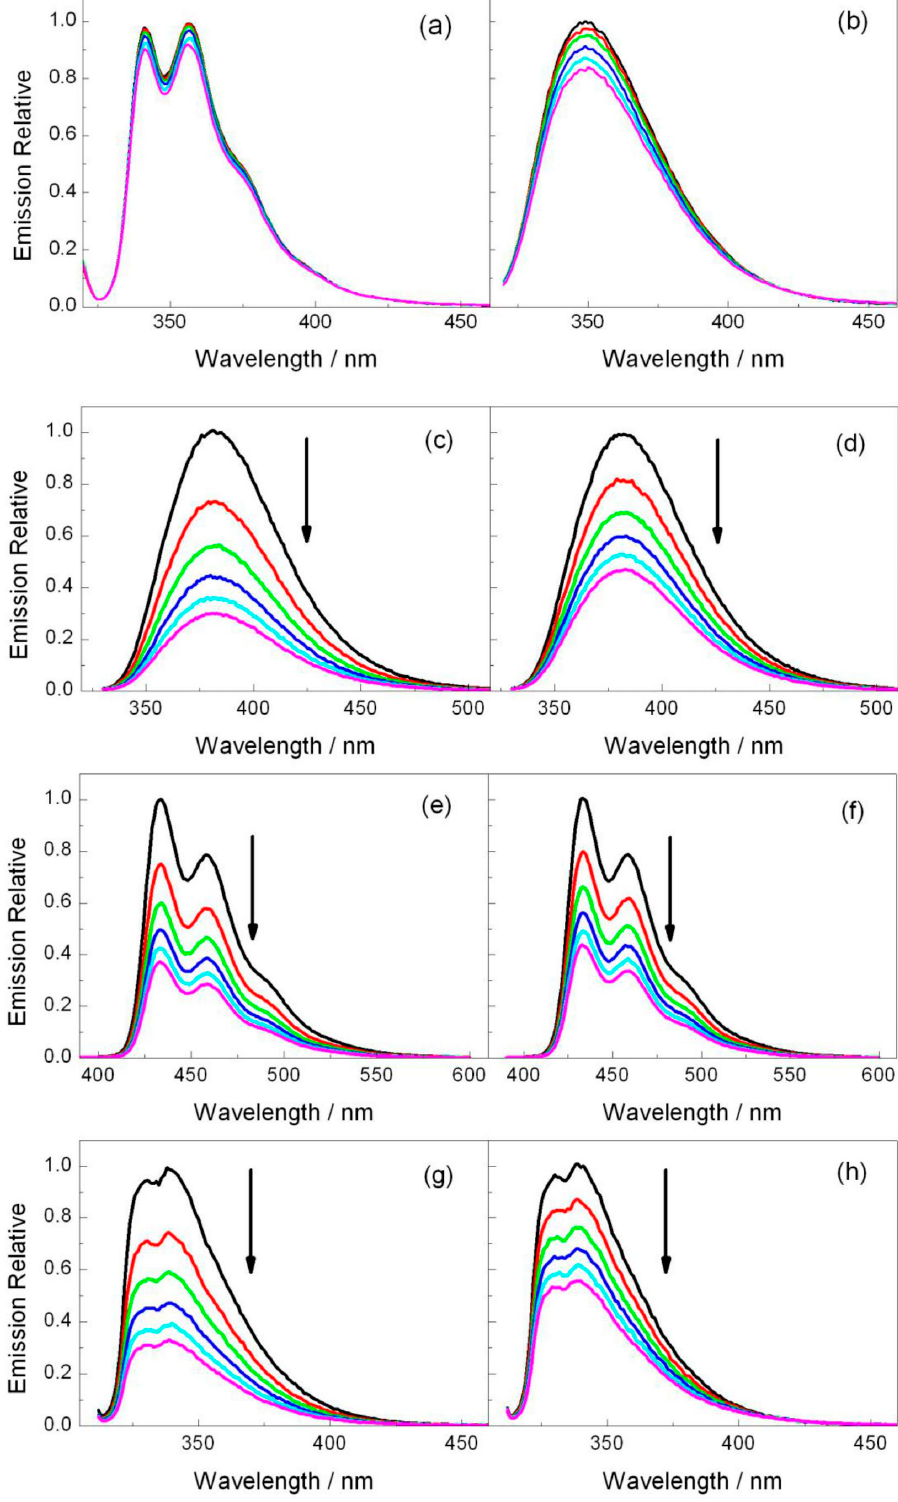
Figure 2. Fluorescence emission spectra for ( a ) CAR ( λ exc = 310 nm) and ( b ) DMA ( λ exc = 310 nm) in the presence of increasing amounts of 2b (0–12.5 mM) as well as ( c , d ) DCN ( λ exc = 310 nm), ( e , f ) DCA ( λ exc = 375 nm), and ( g , h ) CNN ( λ exc = 310 nm) in the presence of increasing amounts of 2a (left panel) or 2b (right panel) (0–12.5 mM). The quencher concentration is 0 (black), 2.5 (red), 5 (green), 7.5 (blue), 10 (light blue) and 12.5 mM (pink).